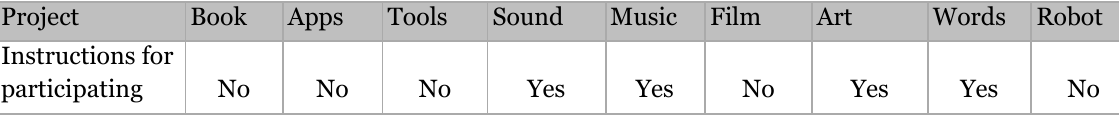
Existence of Instructions to Sustain Lightweight Production on the Website